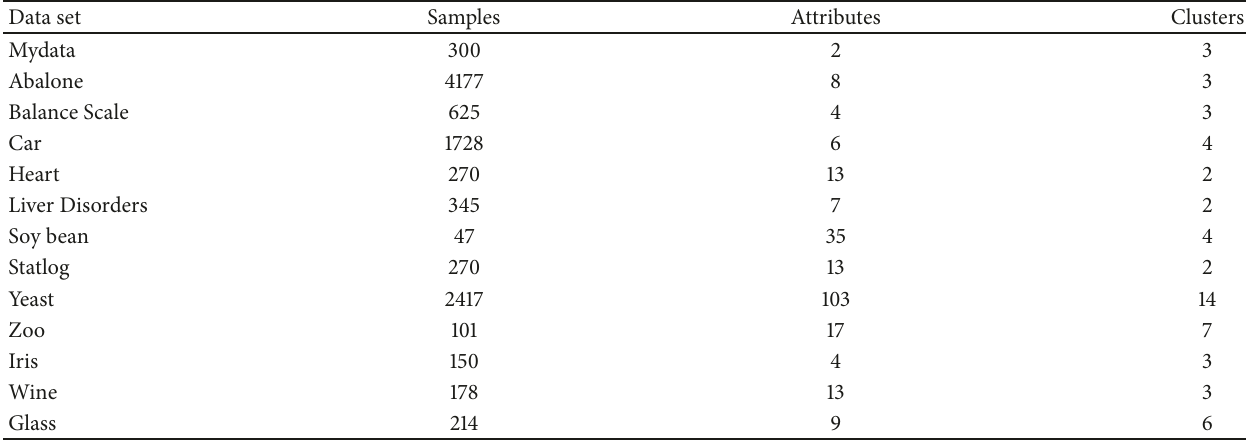
Table 9: Overview of the thirteen data sets.